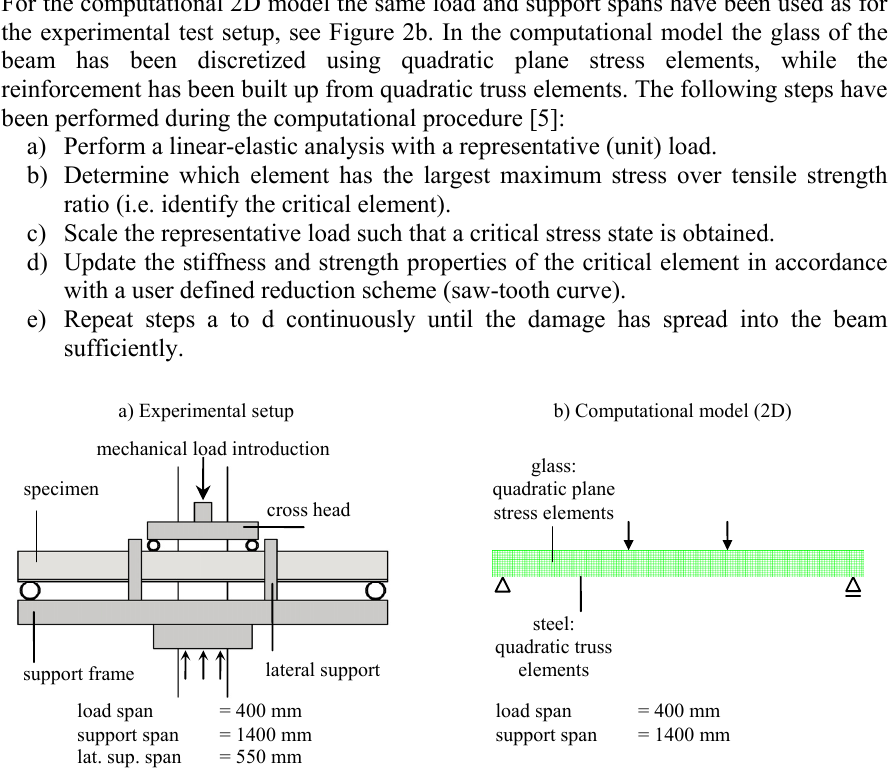
Figure 2: a) Experimental setup, and b) Computational